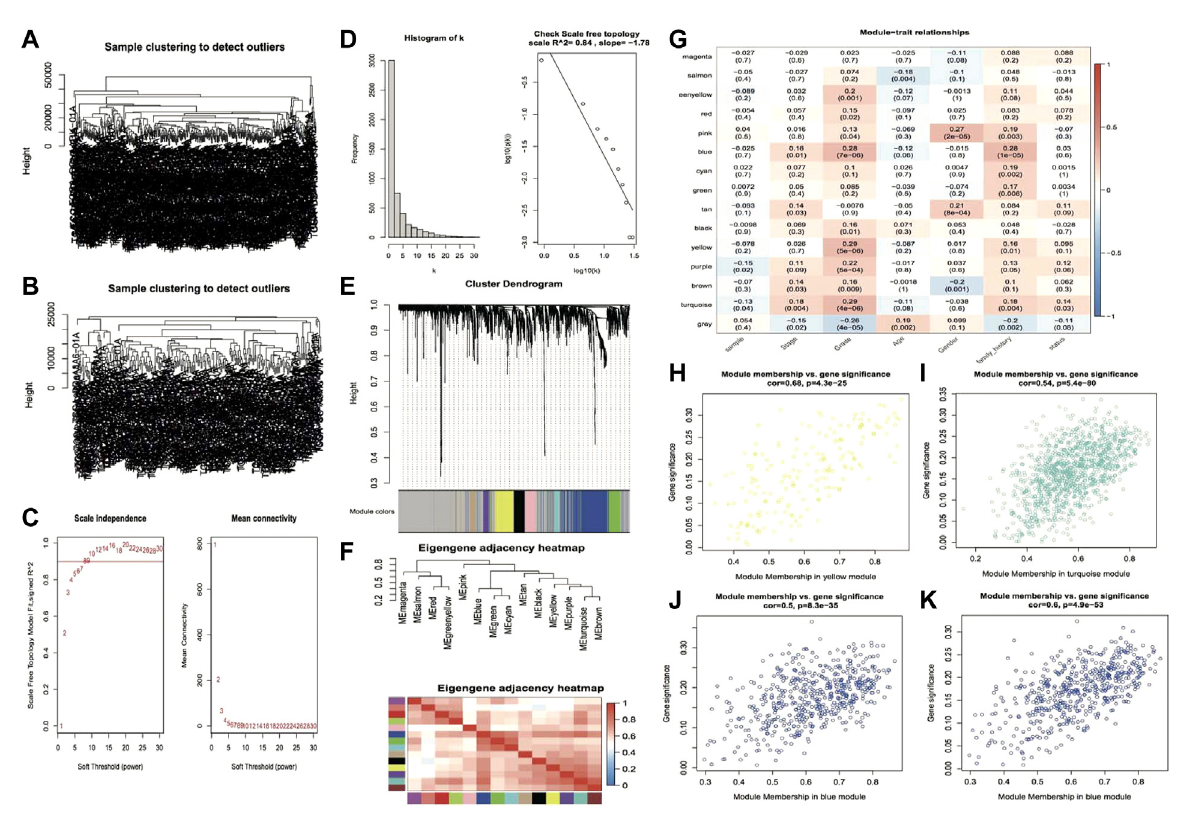
FIGURE 1 The plot of the results of weighted gene co-expression network analysis. (A,B) Clustering tree of samples before and after outlier subjects removal; (C) Soft threshold distribution scatter plot, Soft Threshold (power) indicates the weight, vertical coordinate indicates the correlation of connectivity k with p (k) and average connectivity; (D) Soft Threshold test plot; (E) Clustering tree of genes within modules, the top half of the plot is the clustering tree of genes, the bottom half is the modules clustered according to similarity; (F) Eigenvector gene clustering tree and module correlation thermographic; (G) Module trait correlation thermographic; (H – K) Scatter plots of GS and MM value distribution within modules, rows represent modules, columns are traits, and values are correlation coef fi